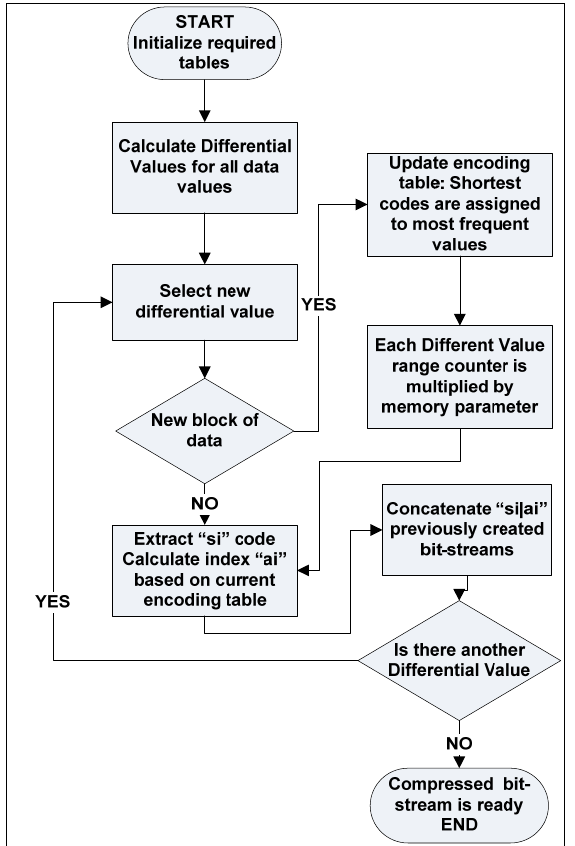
Figure 1. Real ‐ time huffman scheme flow chart. Figure 1. Real-time huffman scheme flow